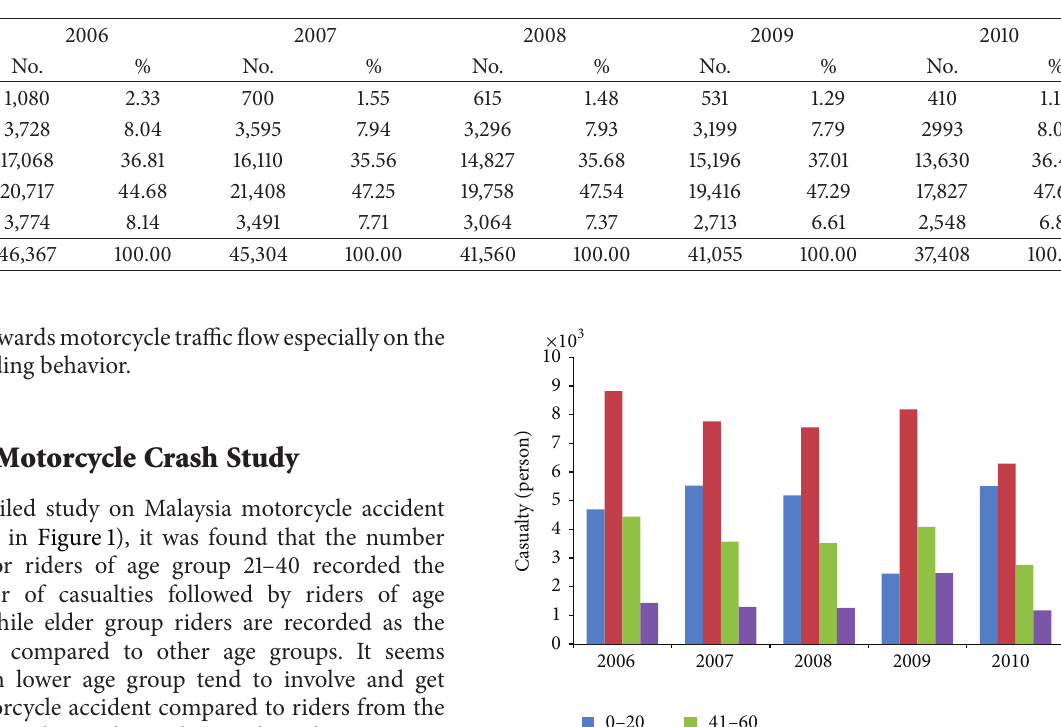
Table 2: Number of vehicle crashes by mode of transport in Malaysia.